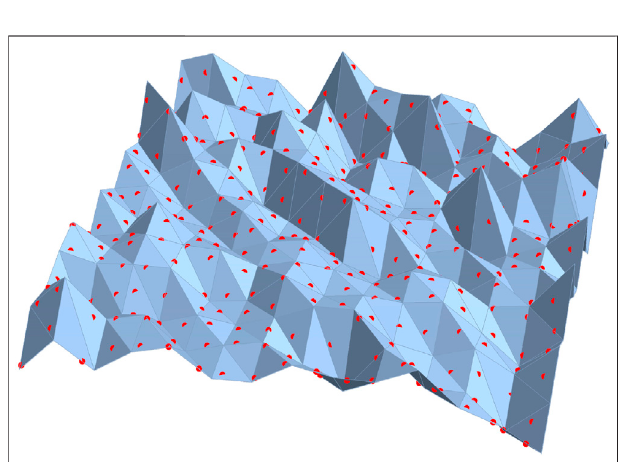
FIGURE 3 | Red points show the possible probe particle positions on the discrete areas selected during the surface discrete sampling (cf. Figure 1